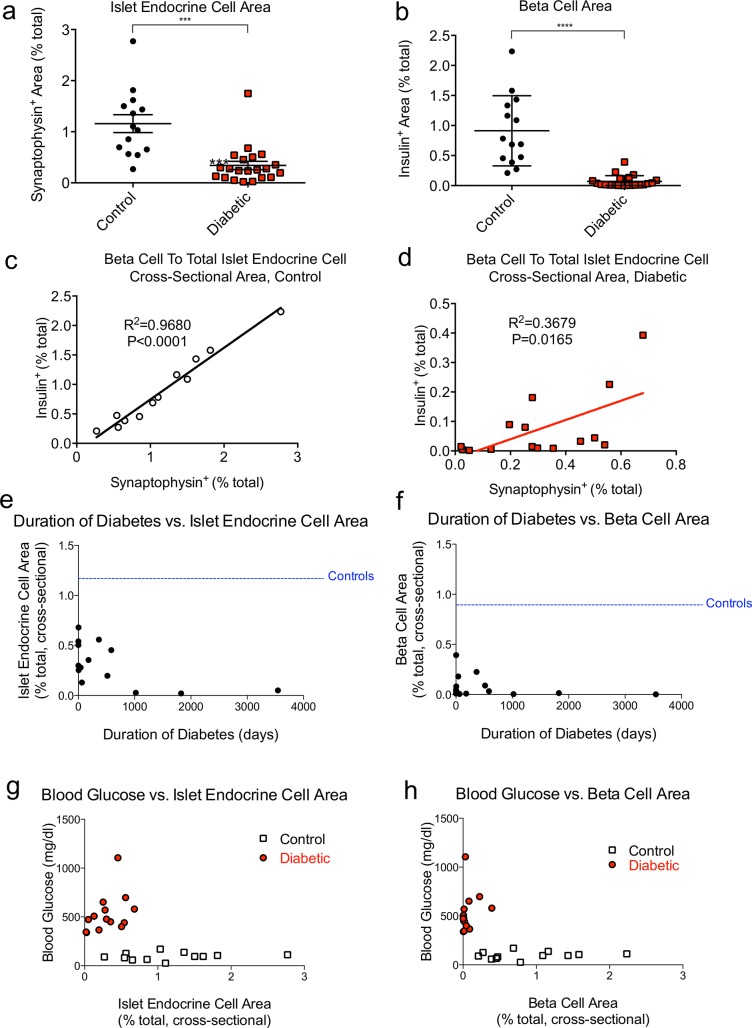
Islet endocrine cell and β-cell area are profoundly reduced in pancreata of diabetic dogs.(a-b) Quantification of (a) islet endocrine (synaptophysin+) cross-sectional area and (b) β-cell (insulin+) cross-sectional area, expressed as % total pancreas area per section. (c-d) Comparison of insulin+ and synaptophysin+ area in (c) control dogs and (d) diabetic dogs. (a-b) mean ± SEM for 14 control and 21 diabetic dogs. ***, p<0.001; ****, p<0.0001. Synaptophysin area and insulin area are correlated in (c) controls (R2 = 0.9680, p<0.0001) and (d) diabetics (R2 = 0.3679, p = 0.017) (e-f) Islet endocrine cell area and β-cell area are not correlated with duration of diabetes. Duration of diabetes vs. islet endocrine area (e) or β-cell area (f). Blood glucose vs. islet endocrine cell area (g) or β-cell area (h). Islet endocrine cell area or β-cell area expressed as % total pancreas area per section. Blood glucose is correlated with islet endocrine cell area (R2 = 0.26, P<0.05) and β-cell area (R2 = 0.31, P<0.05).